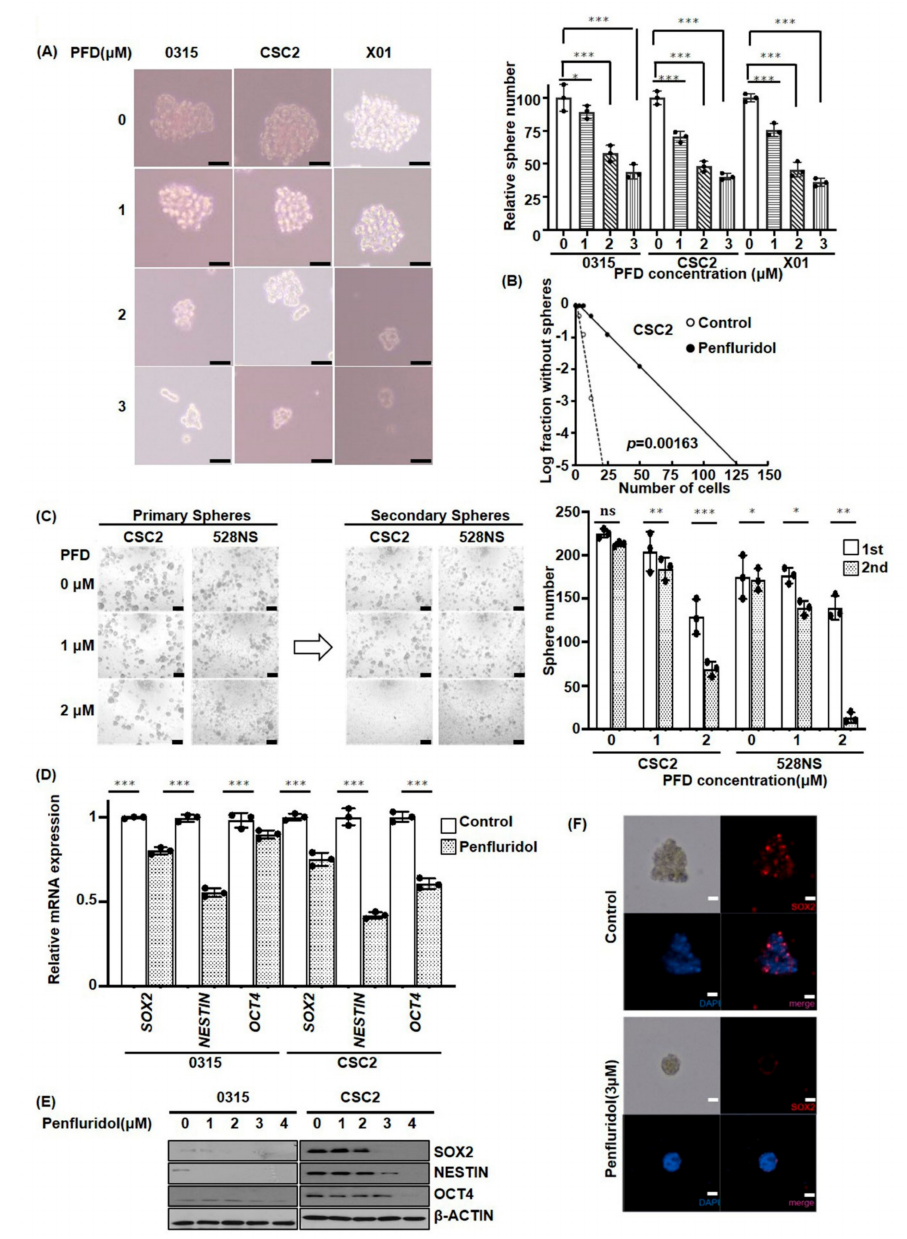
Figure 2. PFD suppresses the stemness of GSCs. ( A ) Sphere formation was tested in 0315, CSC2, and X01 GSCs. Following 1, 2, and 3 µ M PFD treatment, the number of sphere formations was counted by phase contrast microscopy at 48 h (* p < 0.05, *** p ≤ 0.001, when compared with no treatment, Scale bar: 100 µ m). ( B ) Limiting dilution assay was performed in CSC2 cells following 2 µ M PFD treatment or its control. ( p = 0.00163) ( C ) The 528 and CSC2 GSCs were treated with 1 and 2 µ M PFD, respectively. Twenty-four hours later, the number of sphere formations was counted by phase contrast microscopy (Scale bar: 100 µ m). The same procedure was then repeated, and secondary sphere formation was counted (ns; no significance, * p < 0.05, ** p ≤ 0.01, *** p ≤ 0.001, when compared with no treatment). ( D , E ) RT-qPCR and western blotting analyses for stemness factors, including SOX2, OCT4, and NESTIN genes normalized to GAPDH or β actin, in response to PFD treatment. Data are presented as the mean ± SD of triplicate qPCR assays (*** p ≤ 0.001, when compared with no treatment). ( F ) Immunocytochemistry for the stemness factor, SOX2 in CSC2 cells treated with 3 µ M PFD for 48 h (blue, nucleus; red, SOX2, Scale bar: 100 µ